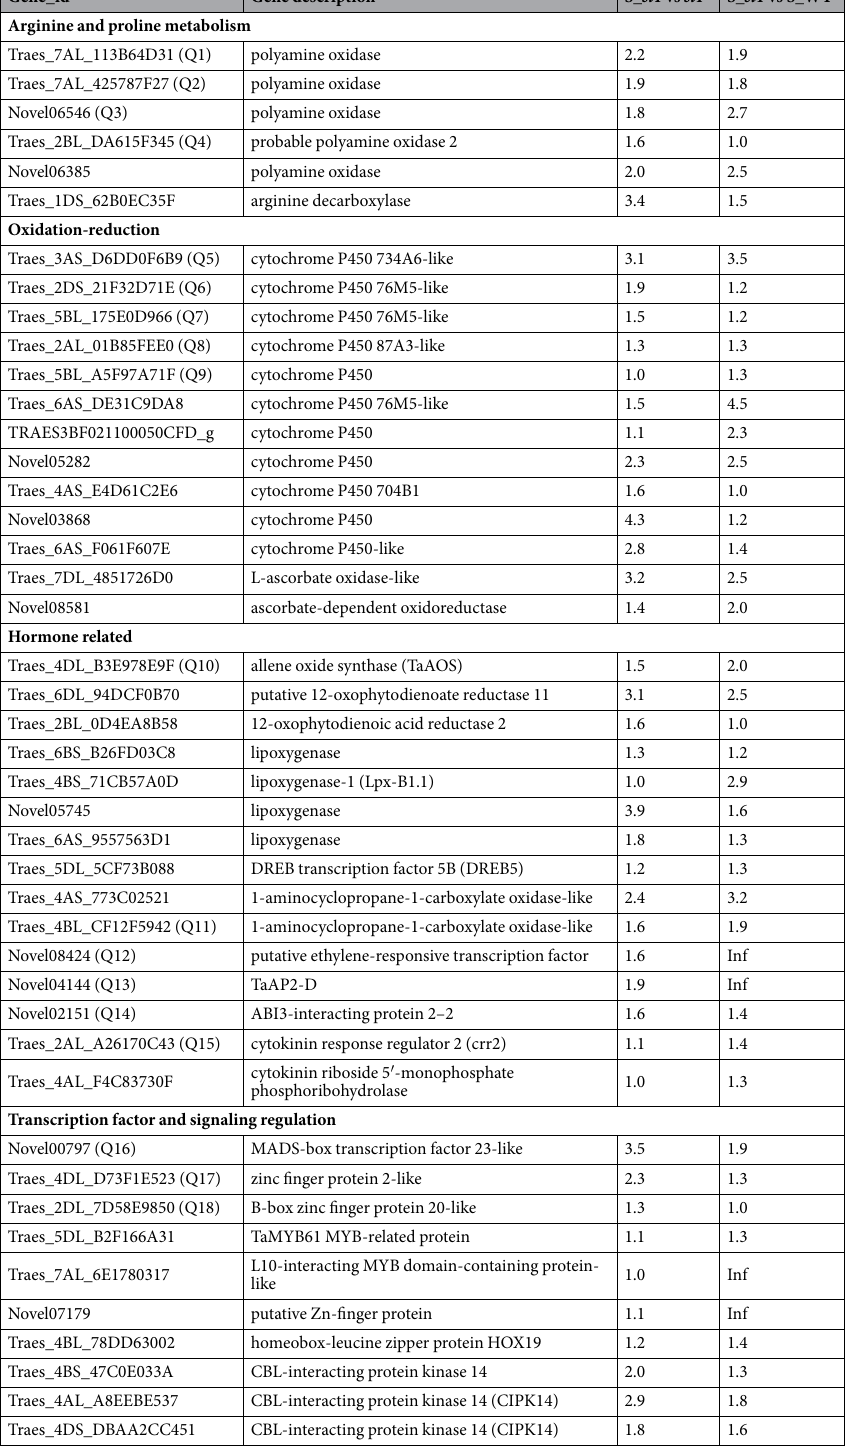
Table 2. List of putative candidate genes for salt tolerance in st1 . These candidate genes were up-regulated in both the S_ st1 vs st1 and S_ st1 vs S_WT comparison groups with the corrected p value < 0.05 and are here classified according to predicted gene function. Q1–Q18 in brackets indicates gene expression was confirmed by qPCR; a The values in the columns are the log2 Fold Change values for the S_ st1 vs st1 or S_ st1 vs S_WT comparison